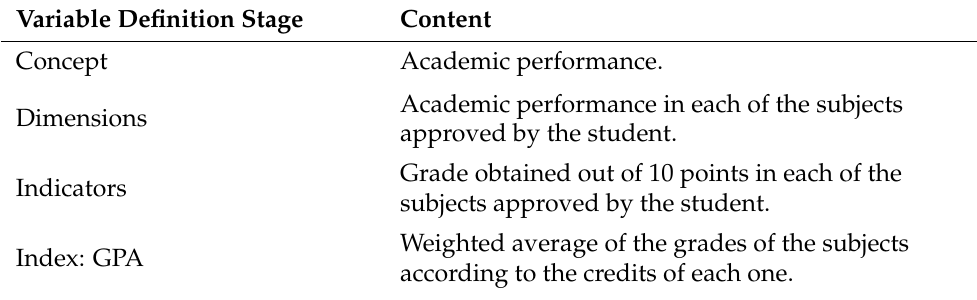
Table 2. Operationalization of academic performance